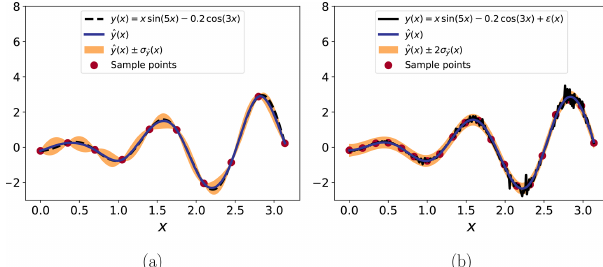
Figure 2. GPR demonstrated on two related test functions: one with no noise (a) and one with noise (b) . In the former case, 10 sample points are enough for a very good estimate (the real function, y , being within 1 standard deviation of the estimate, ˆ y , throughout). Note also how the uncertainty decreases around the sample points in this case due to the lack of noise. In the second case, more samples are needed for a good estimate. The noisy function does at one point exceed even 2 standard deviations away from the estimate, but the underlying (non-noisy) function is well estimated. Note also how the uncertainty level, while more or less constant, is not higher than it was away from the sample points of the non-noisy